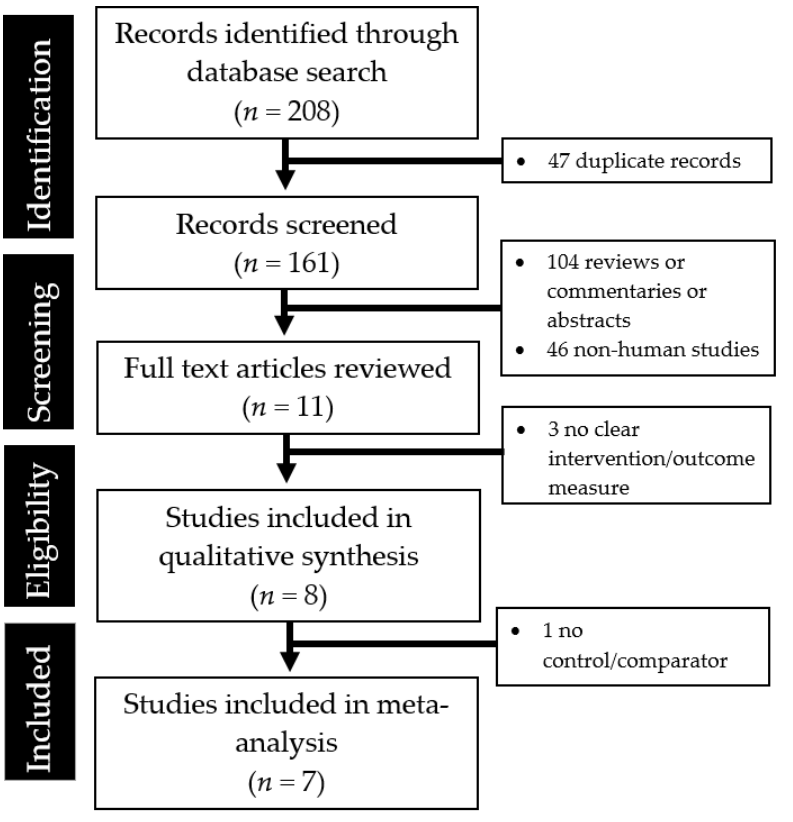
Figure 1. PRISMA flow diagram showing the studies identified during the literature search and abstraction process.